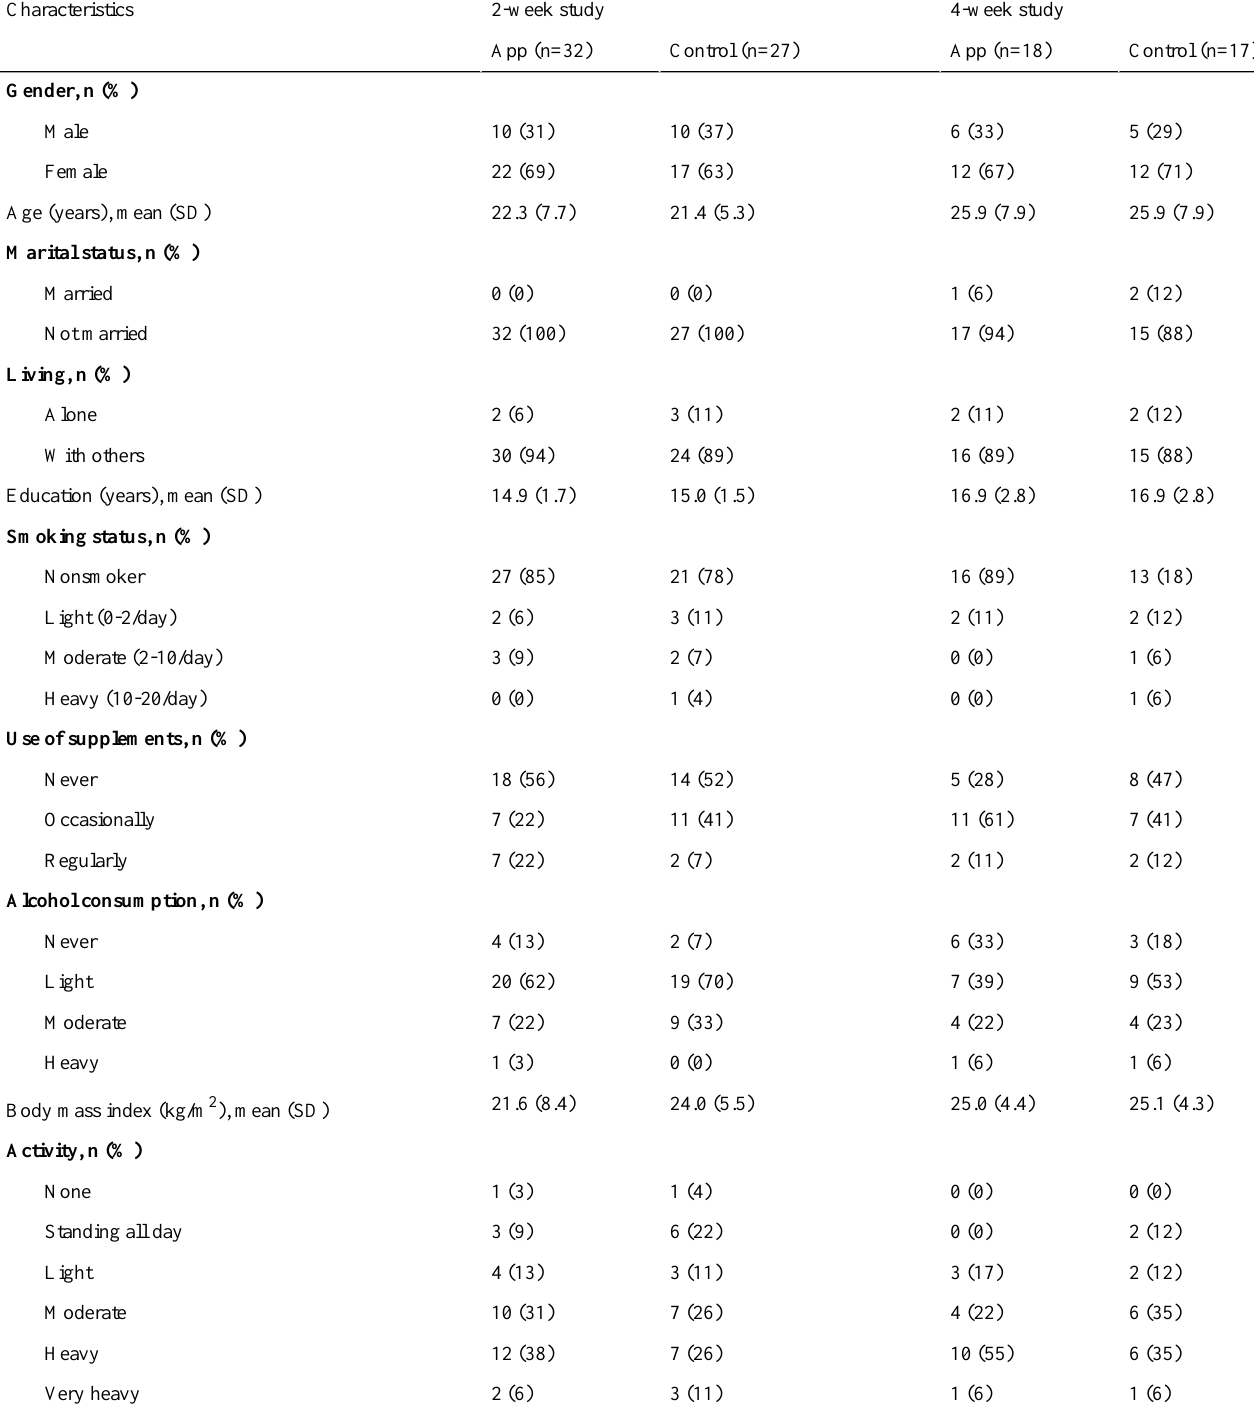
Table 3. Demographic and lifestyle characteristics.